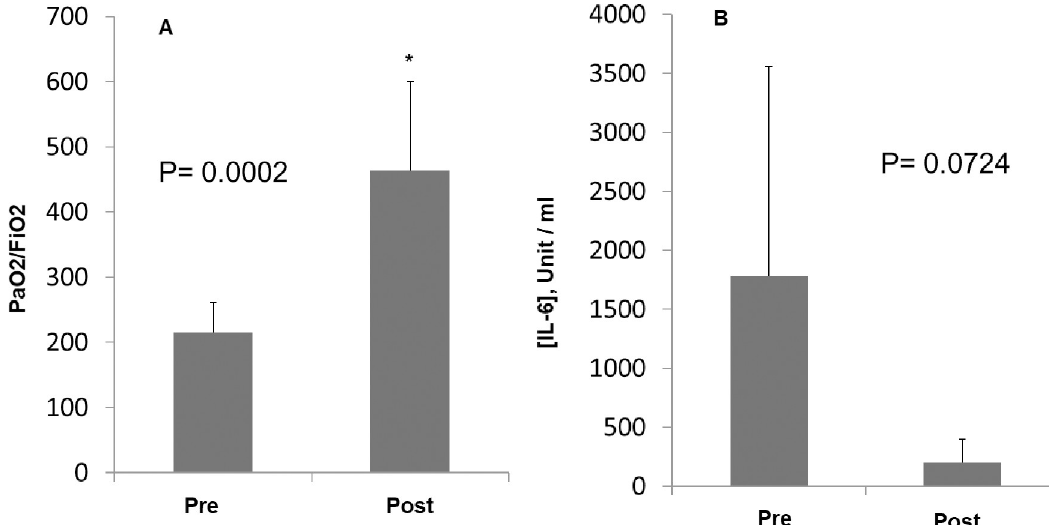
Fig 1. Respiratory and inflammatory marker monitoring before and after adenosine treatment. Panel A)- Adenosine treatment shows a significant improvement in the mean PaO 2 /FiO 2 ratio in 14 patients who received adenosine. Panel B)- The plot shows a post-treatment decline in IL-6 serum level. However, the differences did not achieve statistical significance (P = 0.07). There was no significant treatment-related changes in blood cell counts as well as serum C-reactive protein and Lactate Dehydrogenase (LDH)